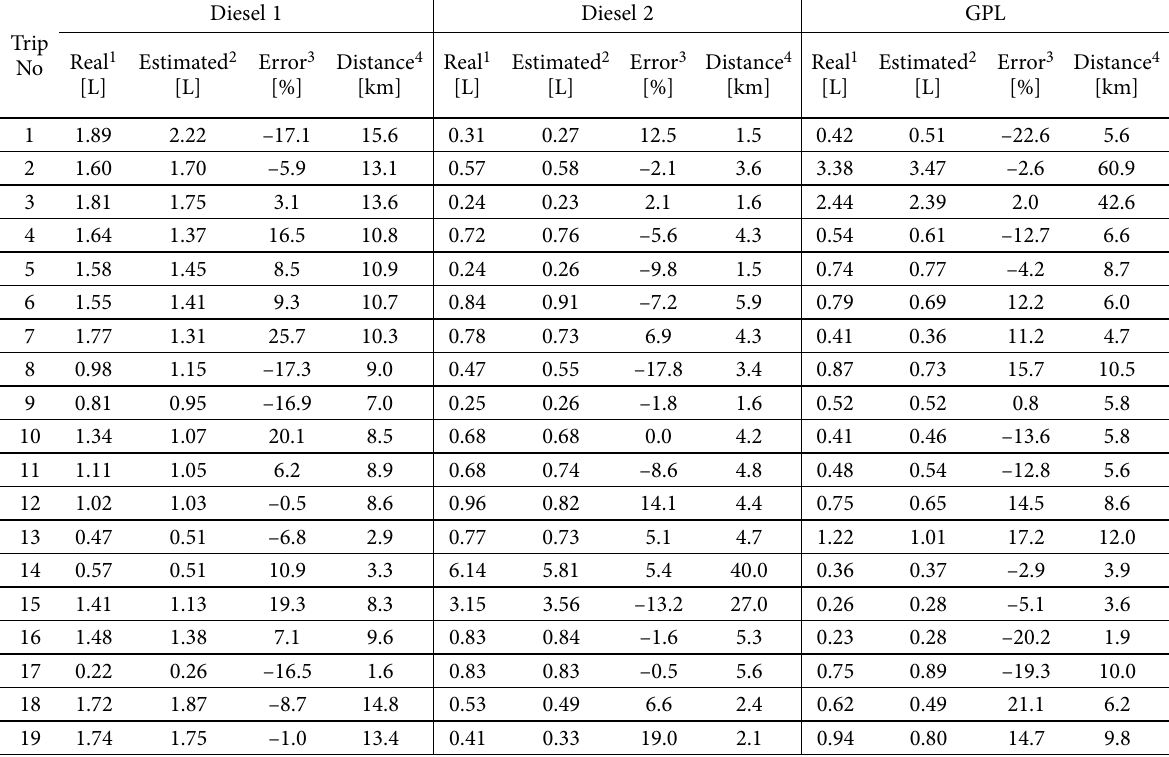
Table. Results obtained from the